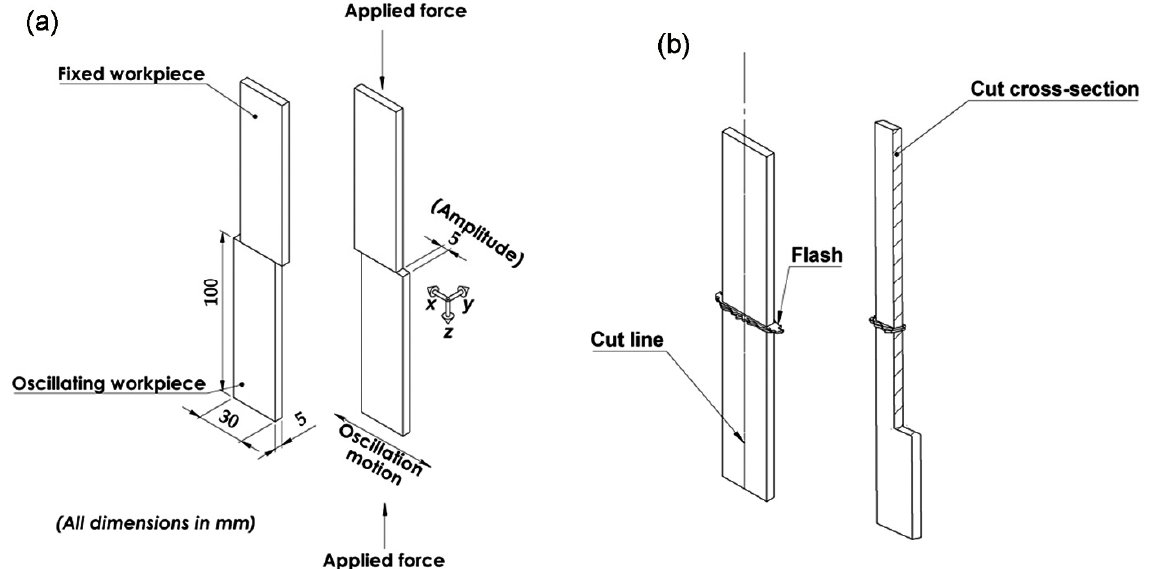
Figure 2. ( a ) Schematic of base plates and their setup in the linear friction welding machine. ( b ) Schematic of the metallographic sample cut away from the welded coupons.